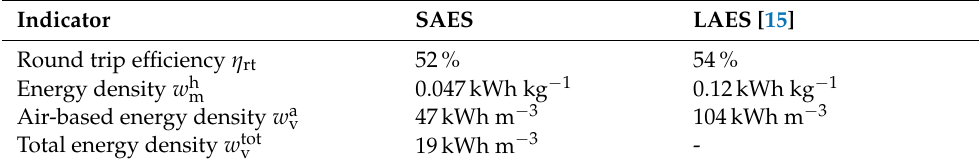
Table 3. Key indicators for the reference case of SAES and for